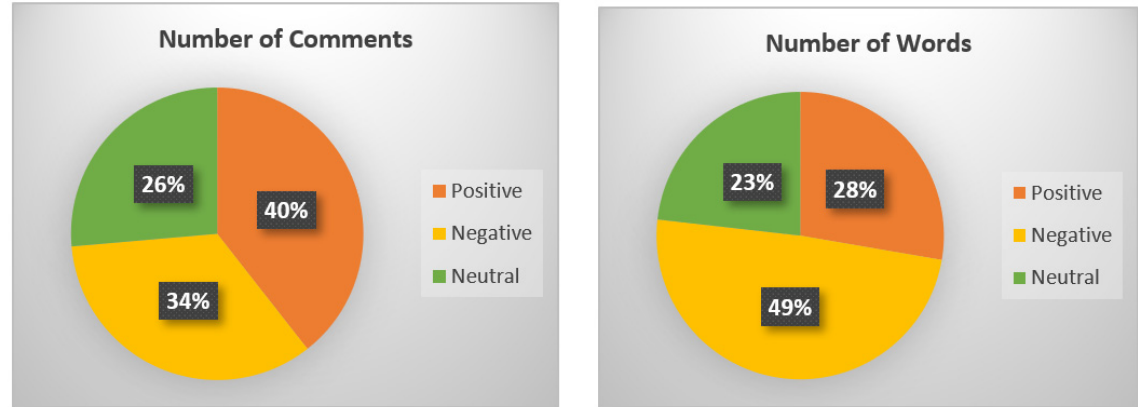
Figure 2. A comparison of the sentiment score values of Instagram comments and words in terms of the number of neutral, positive, and negative comments.